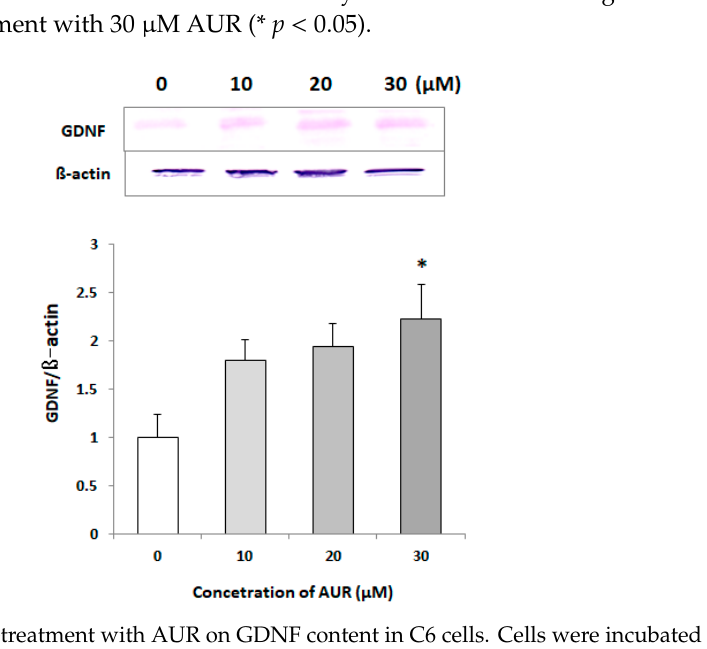
Figure 3. Effects of AUR-treatment with AUR on GDNF content in C6 cells. Cells were incubated with various concentrations (0, 10, 20, and 30 μ M) of AUR for 50 h. The results are presented as the mean ± SEM ( n = 3). Significance difference in values between the non-treated and AUR-treated cells: * p < 0.05.